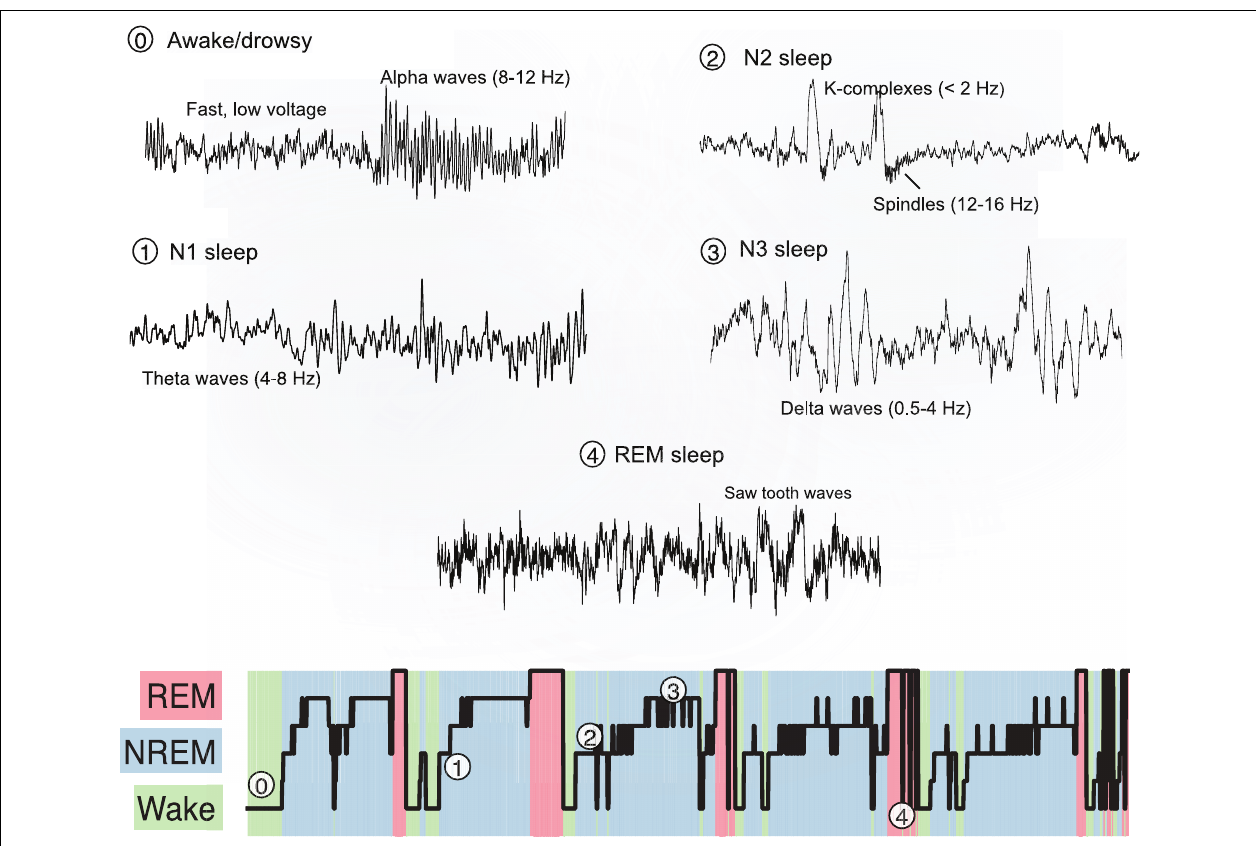
FIGURE 1 | Electroencephalography activity during